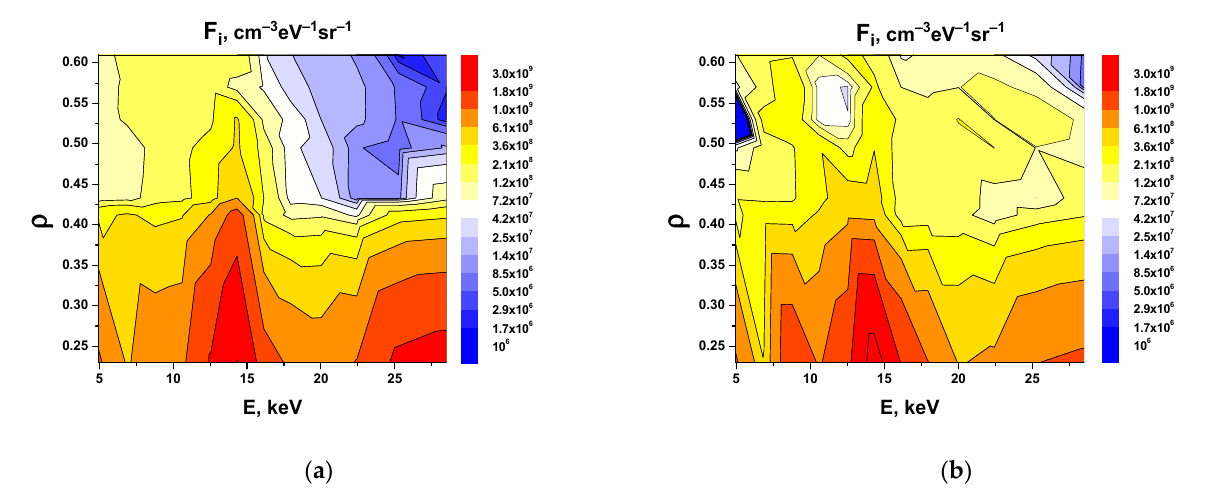
Figure 18. Experimental energy and spatial fast D ion distribution before ( a ) and during ( b ) TAE reconstructed using the active NPA measurements (discharges ##39001, 39006-9, 39013, 39015 with similar parameters; energy spectra were measured at different spatial locations from discharge to discharge).